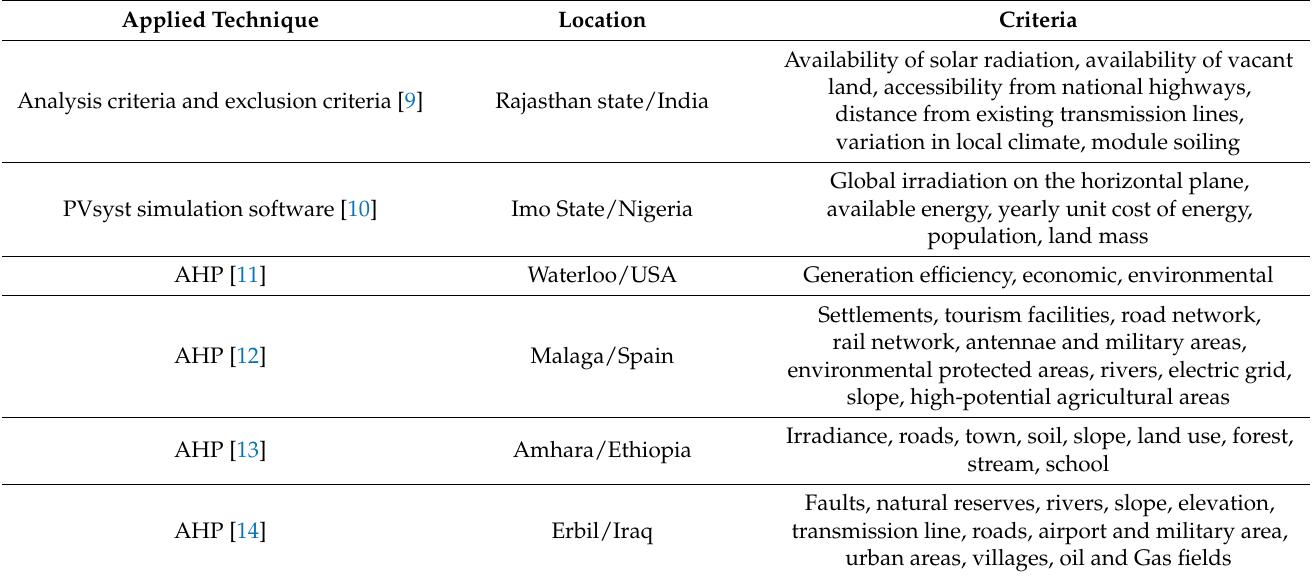
Table 1. Review of the literature on solar plant site